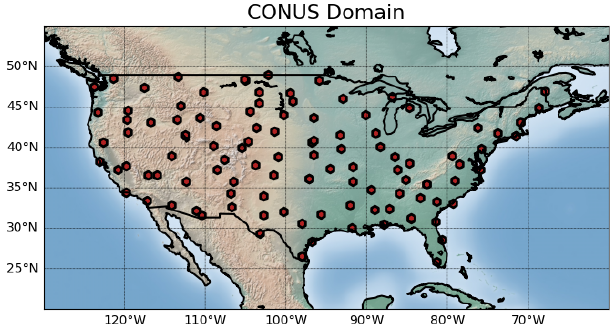
Figure 3. Map illustrating the CONUS domain. Red dots represent the locations of the USCRN soil moisture